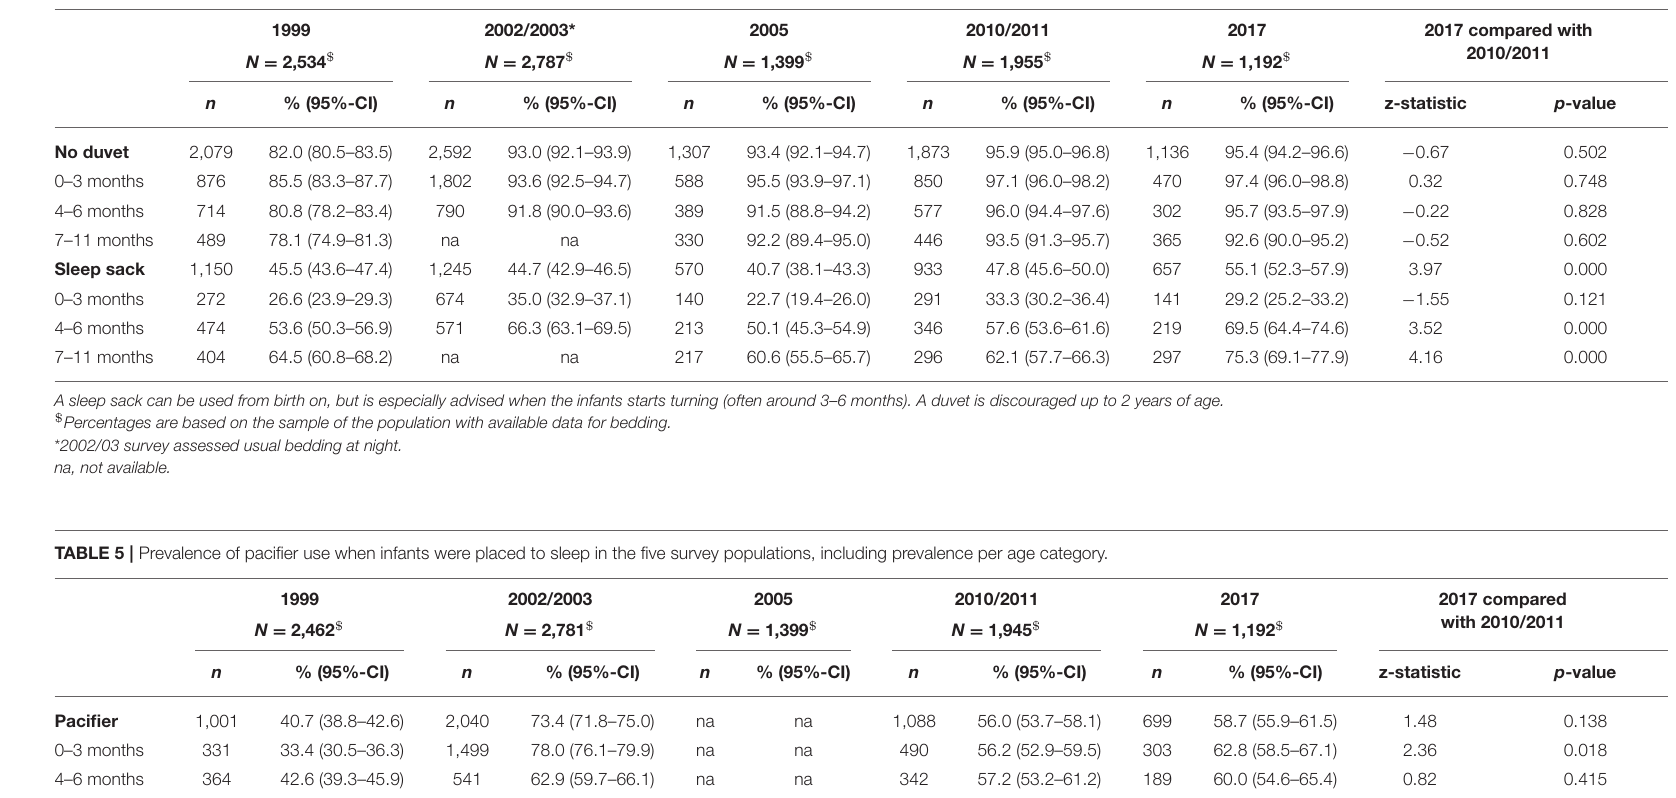
TABLE 4 | Prevalence of a sleep sack and not using a duvet in the five survey populations, including prevalence per age